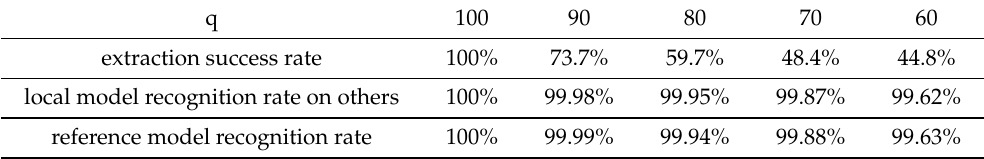
Table 6. Effects of different compression qualities on steganographic information